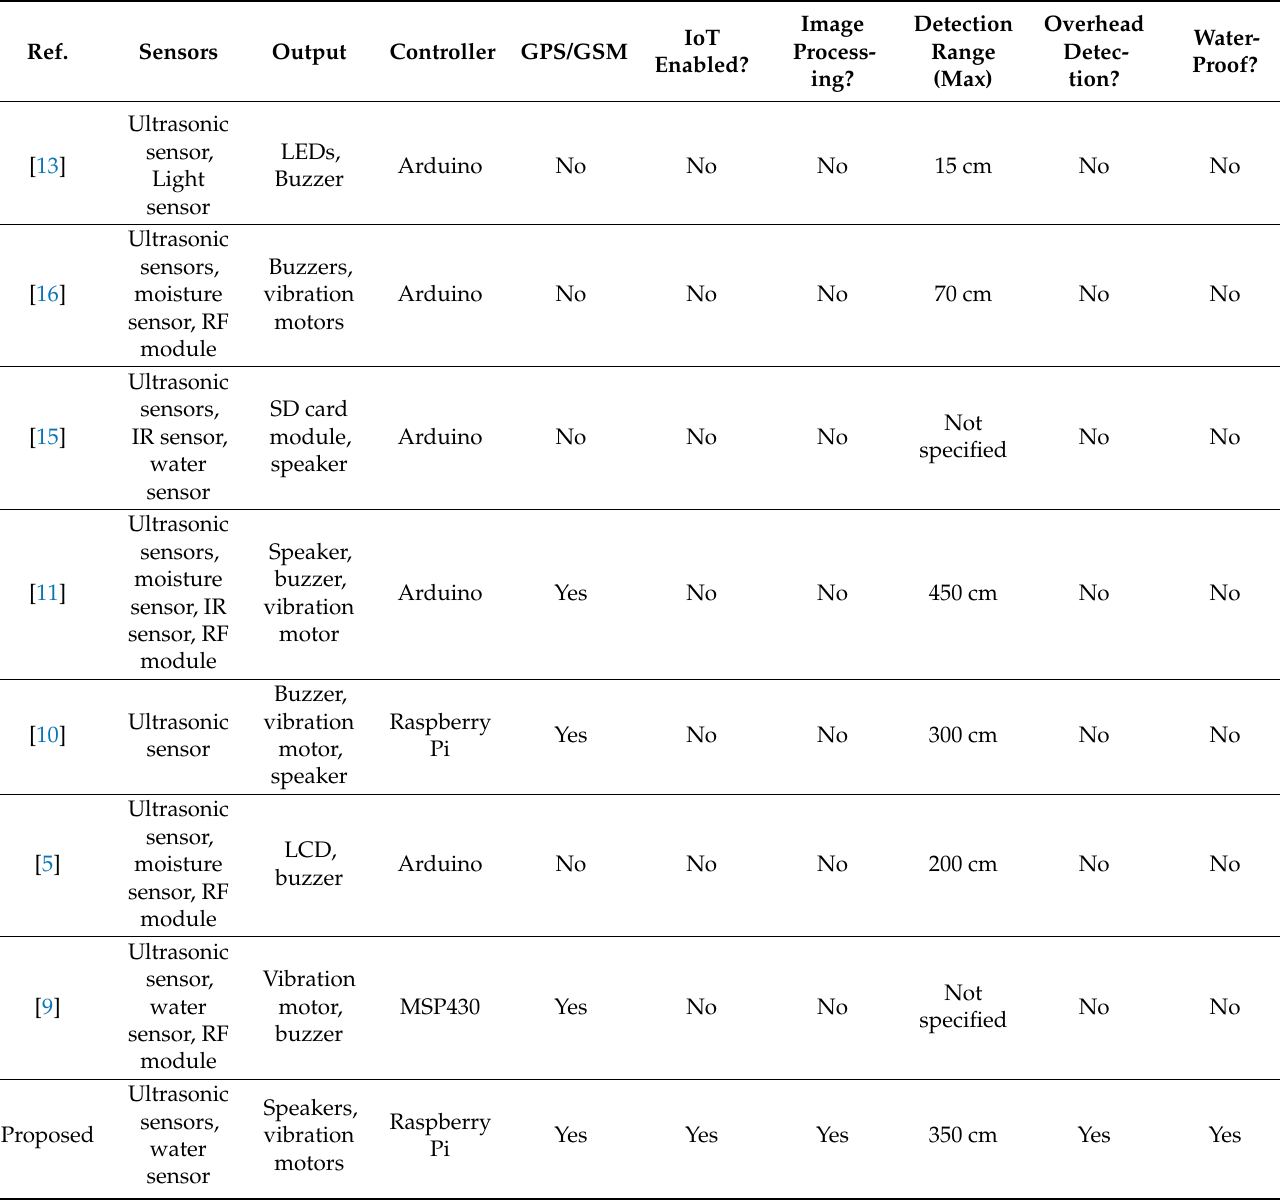
Table 4. Comparison with existing